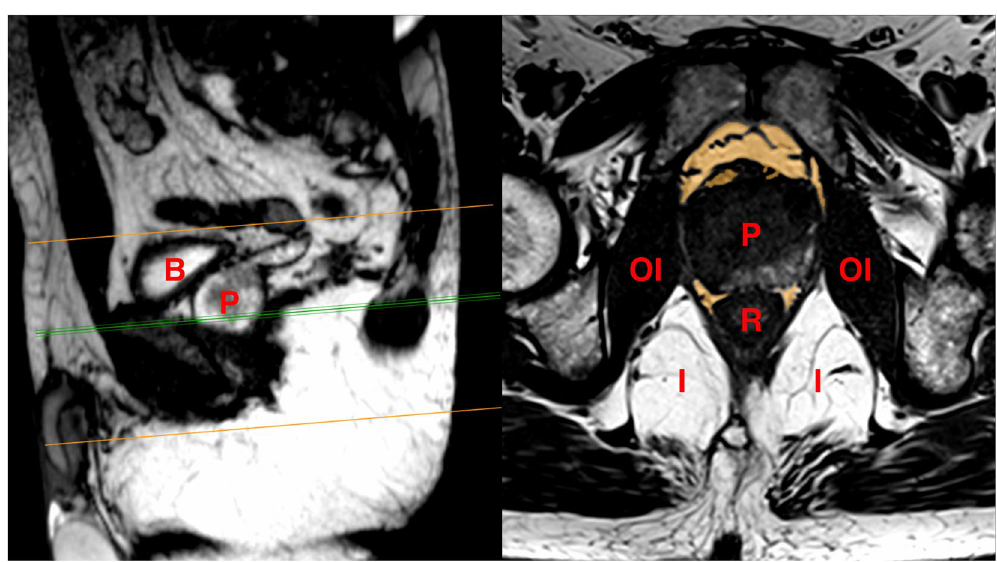
Figure 3. Segmentation technique to measure the volume of periprostatic fat (masked in yellow) from multiple sequential slices of axial T 1 weighted MRIs. P = Prostate; B = Bladder; OI = Obturator internus muscle; R = Rectum; I = Ischiorectal